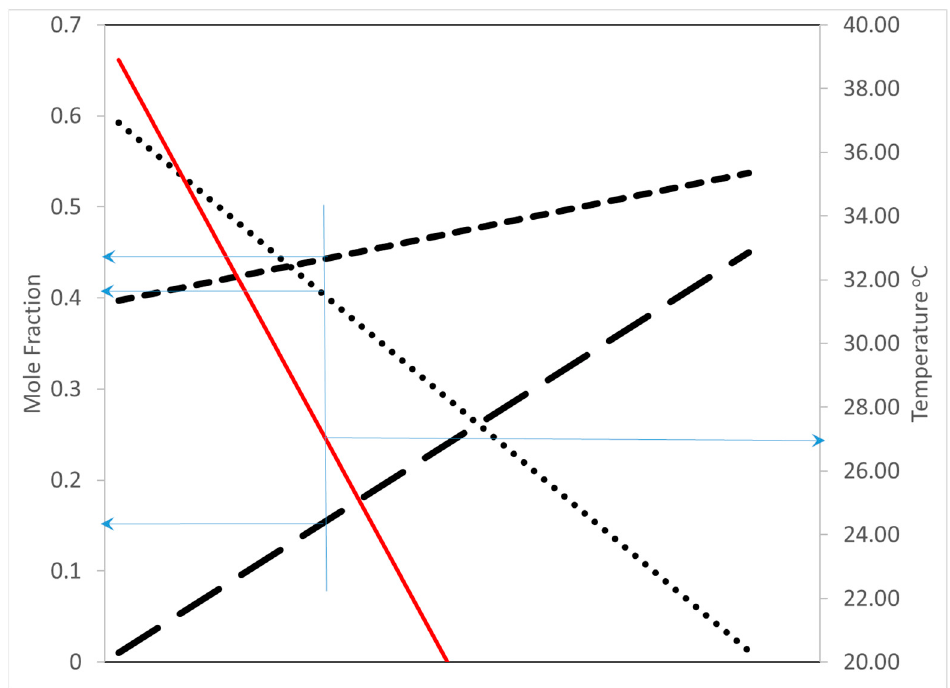
Figure 4. A dew point molar composition of 52 °C was calculated based on the fugacity coefficient according to modified Raoult’s law. Long dashed line—propane; dotted line—butane; small dashed line—pentane; red line—process inlet temperature of the cooling fluid; blue guide lines—composition at 27 °C. Table 4. Temperature, pressure, molar flow, composition, quality and heat load of process streams.